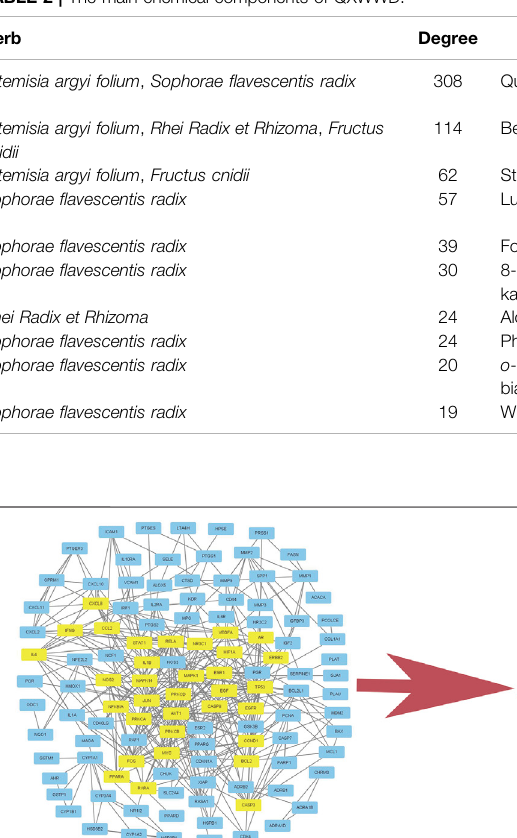
TABLE 2 | The main chemical components of QXWWD.